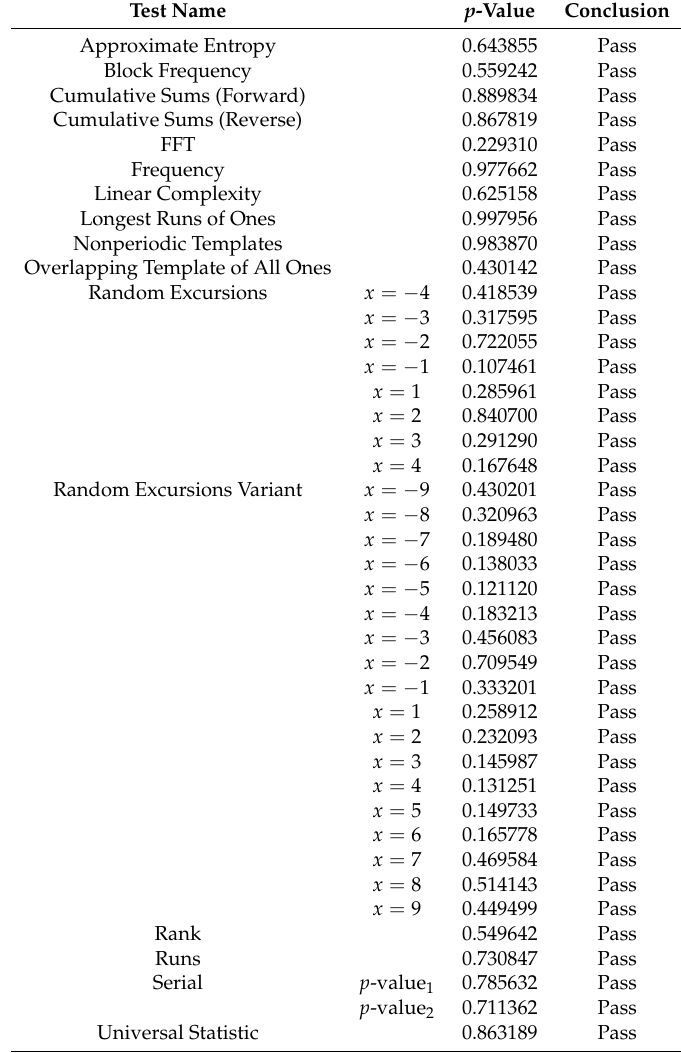
Table 5. Randomness tests by NIST SP